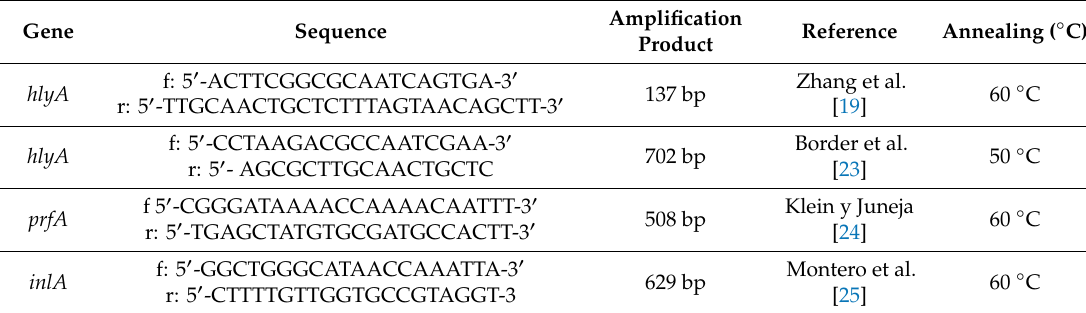
Table 1. Primers used in this